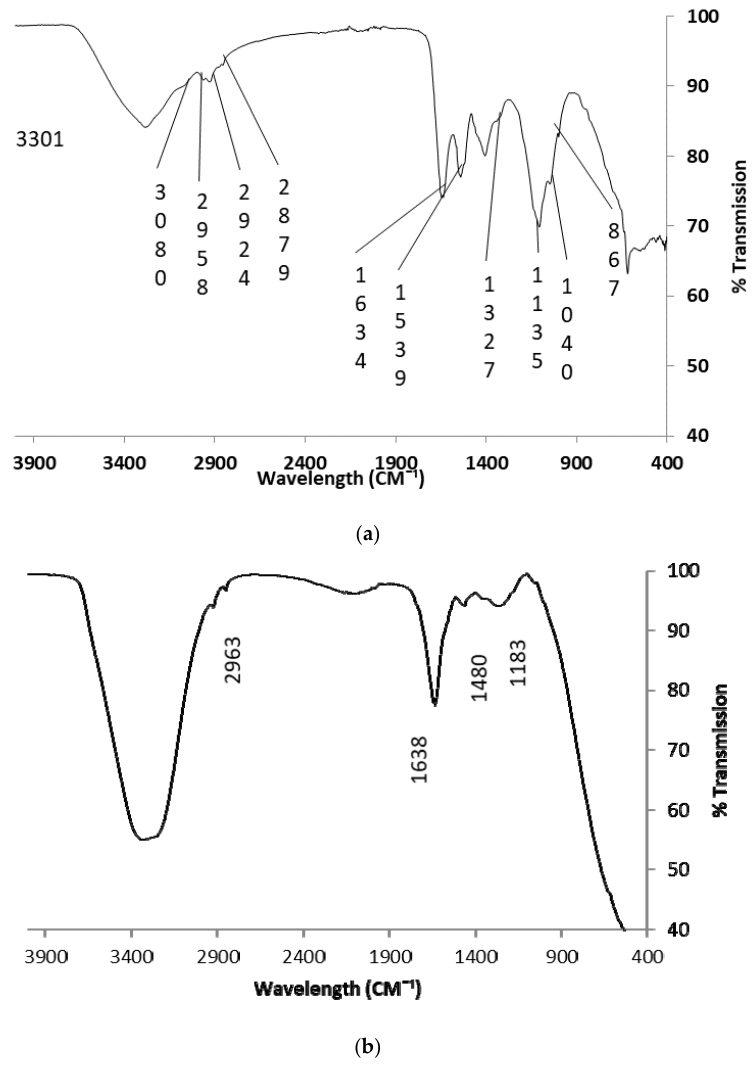
Figure 2. ATR-FTIR spectra of ( a ) raw freeze-dried ACM; ( b ) ACM-stabilized emulsion. Table 1. Functional groups of raw African catfish mucus.